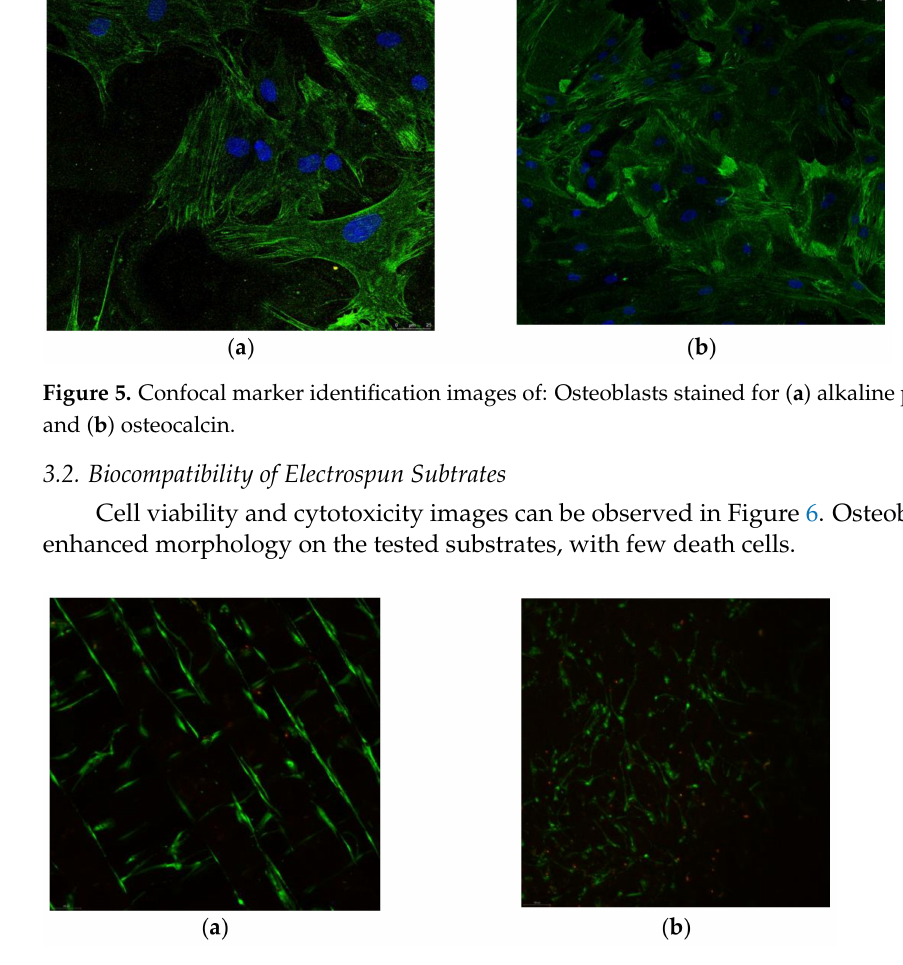
Figure 6. Osteoblasts cell viability tests on ( a ) 3D printed materials and ( b ) electrospun